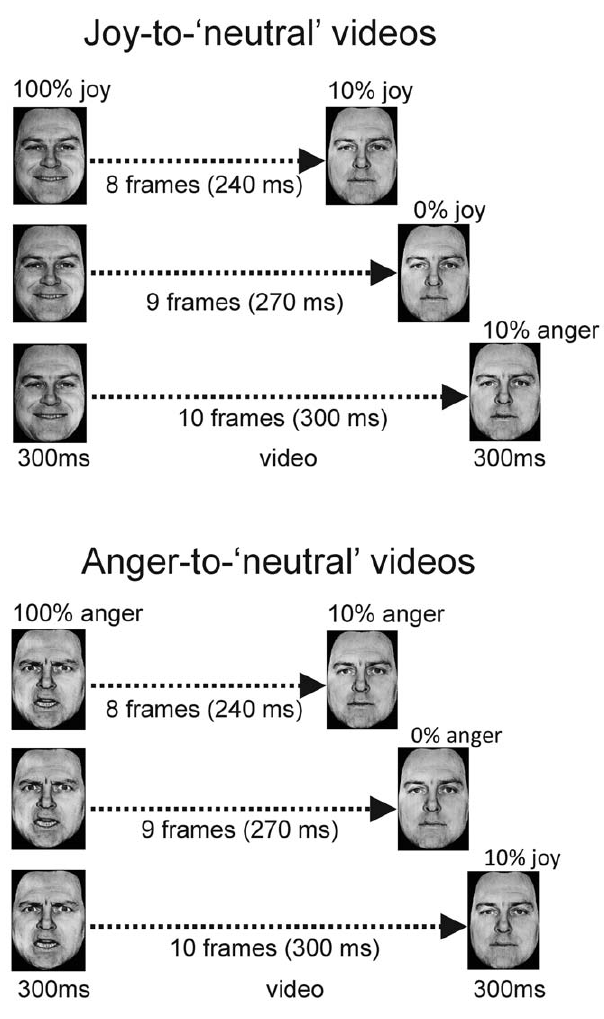
Figure 1. Illustration of the stimulus presentations in Experi- ment 1. Joy-to-‘neutral’ videos started with a facial expression of joy (100%), which gradually morphed into a 10% joy, a neutral or a 10% anger expression (top panel). Anger-to-‘neutral’ videos started with a facial expression of anger (100%), which gradually morphed into a 10% anger, a neutral or a 10% joy expression (bottom